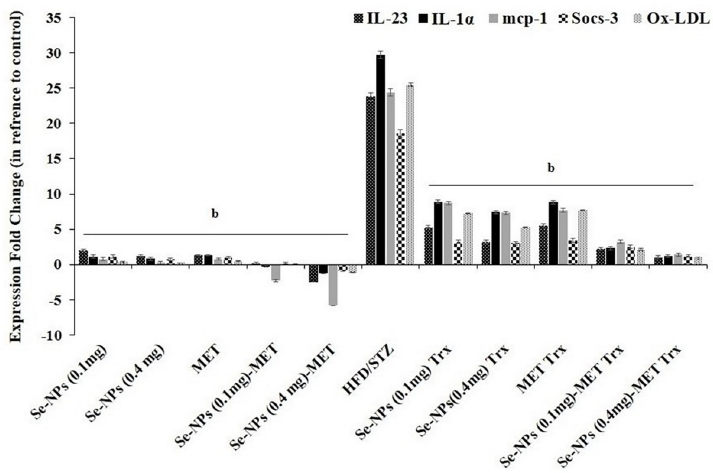
Fig 7. Effect of Se-NPs, MET monotherapy, and combined therapy on hepatic mRNA expression of inflammatory genes in control and HFD/STZ-experimental groups. Values are expressed as fold induction ± SE (the mean of three assays) relative to the mRNA level in the control and were normalized to β -actin RNA level. Significant changes (p < 0.01) with respect to HFD/STZ-experimental rats are expressed by the letter b.